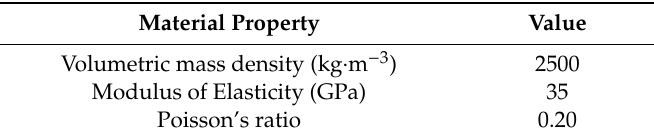
Table A1. Material properties used in the calculation of γ FvK and G i numbers for the engineered thin